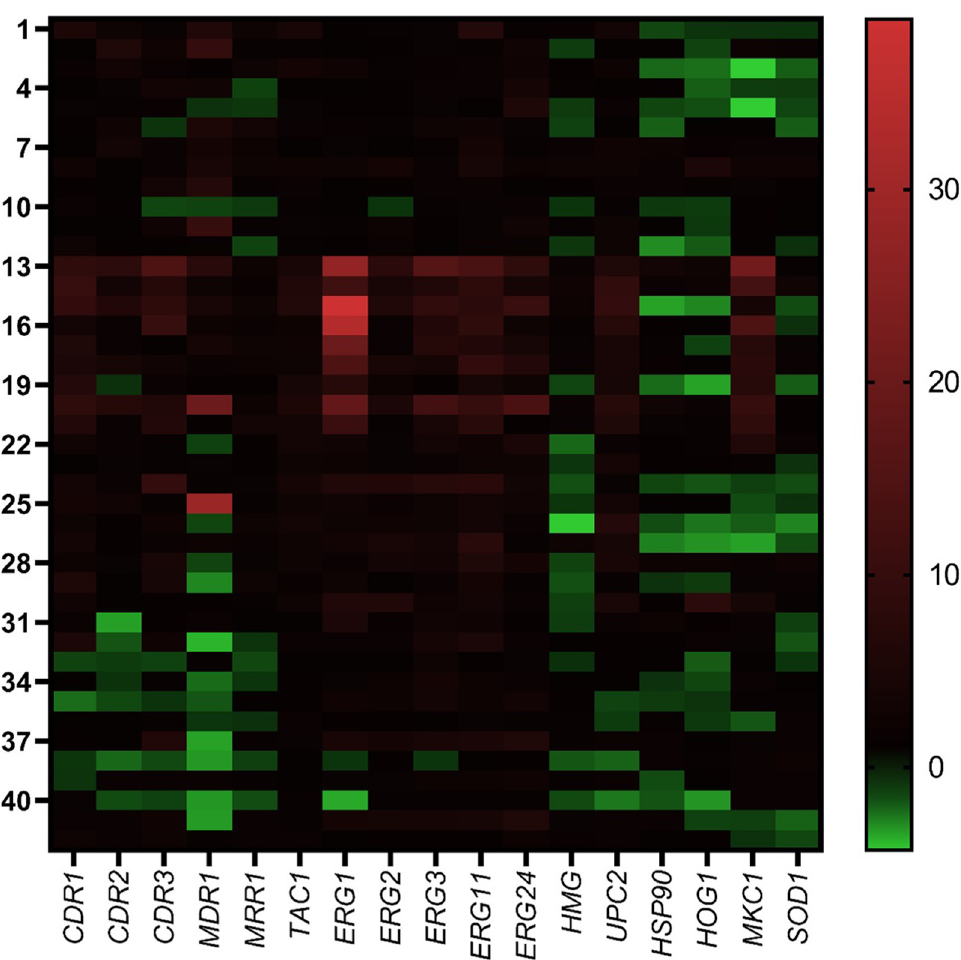
Fig 2. Heat map demonstrating the comparison between the inducible expression of azole resistance genes among the R-WM (Isolate 1–12), R-WTM (13–32), and S (33–42) isolates. ‘Y’ axis is representing the isolates used and ‘X’ axis representing the genes tested. The scale representing the upregulation (in red) and downregulation (in green) of the genes among resistant and susceptible